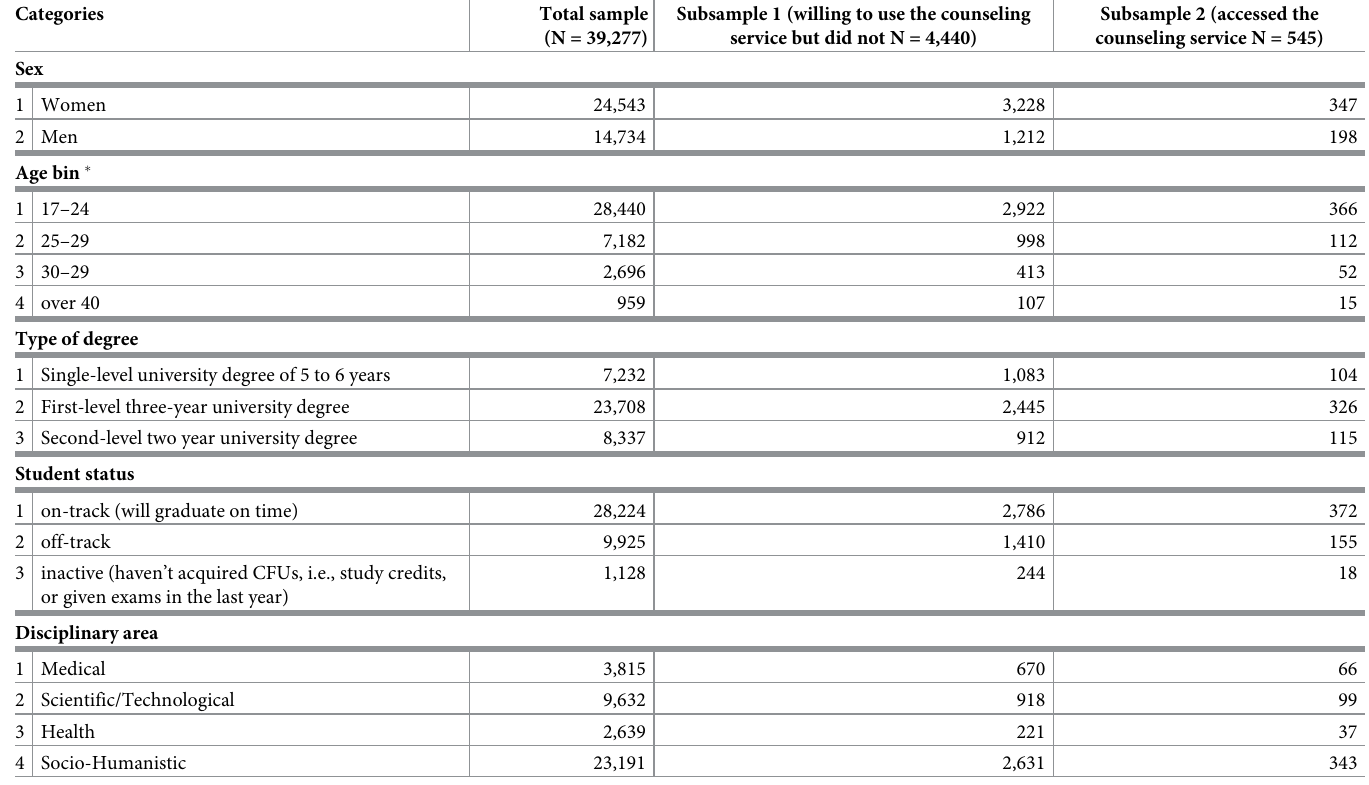
Table 1. Supplementary variables with their respective categories. This table collects answers to the first part of the survey. Categories Total sample